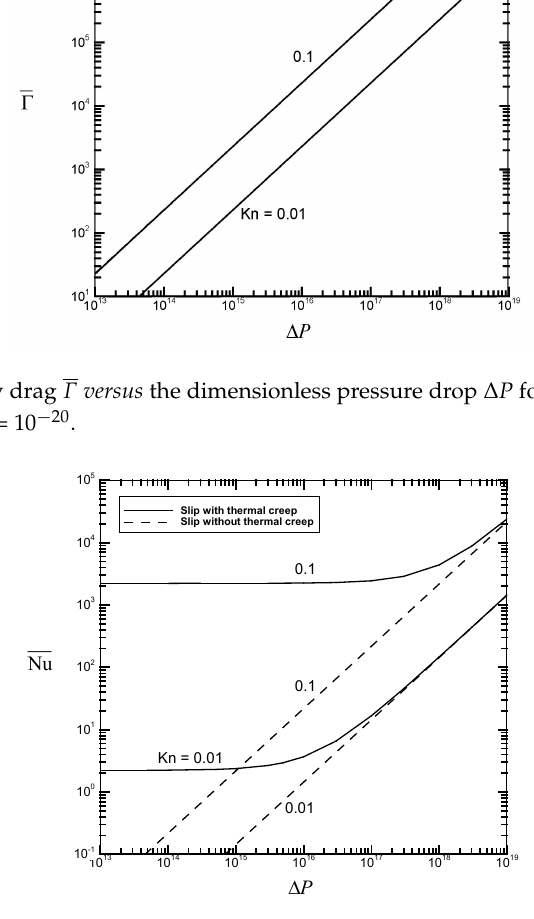
Figure 5. Average heat transfer rate Nu versus the dimensionless pressure drop Δ P for different values of Kn with GrL = 10 2 and Ec = 10 −20 .